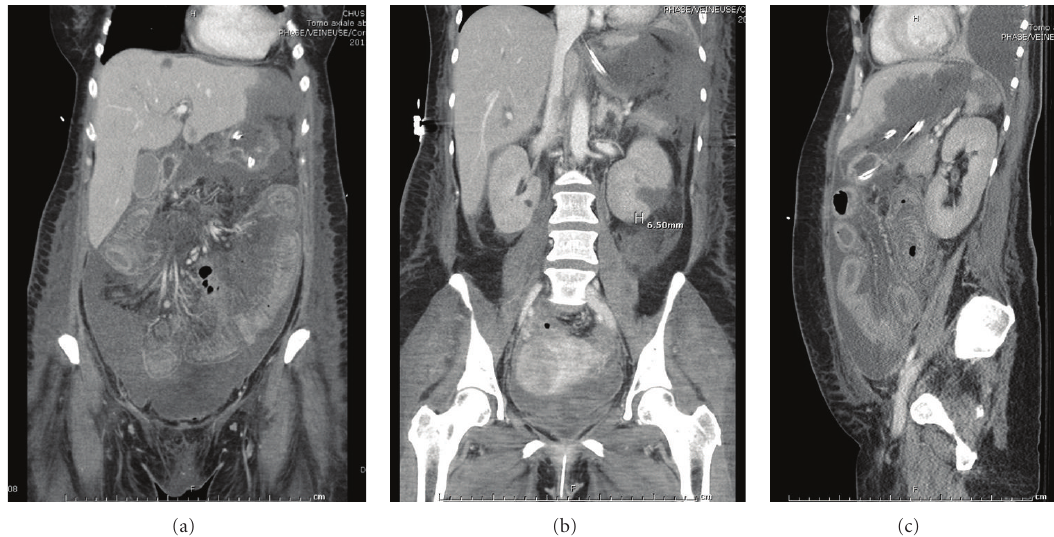
Figure 3: An abdominal CT scan documented a lack of enhancement of the distal portion of the small bowel, including the ileostomy, compatible with ischemia (a). Numerous splenic, hepatic, and renal infarcts were visible (b and c).